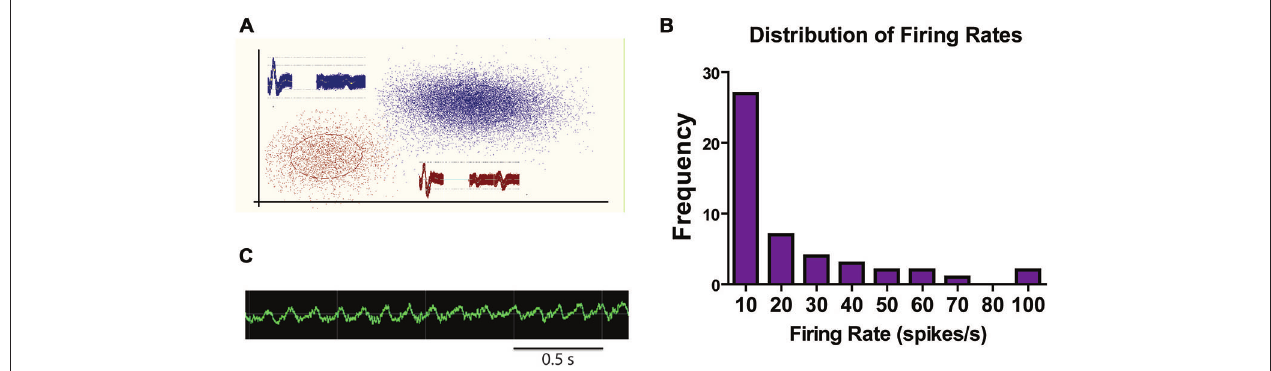
FIGURE 4 | Sample traces and summary of firing rates. (A) Sample traces from a tetrode within the LHb with two distinct units. (B) Sample raw LFC signal from LHb during a recording session. (C) Frequency count of firing rate ranges for all recorded LHb units.